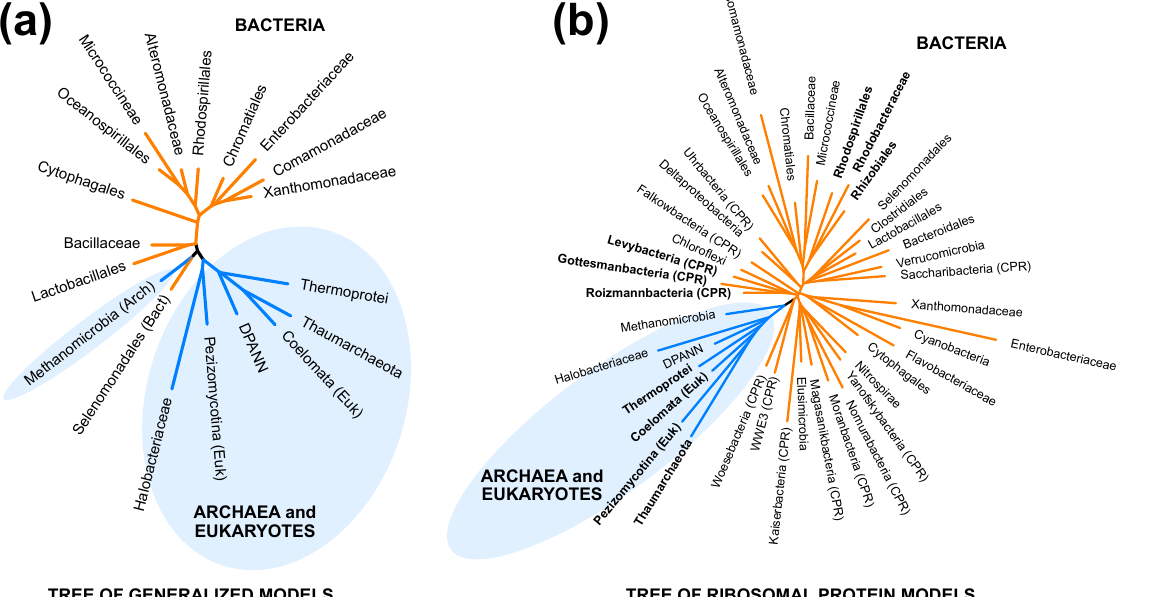
TREE OF RIBOSOMAL PROTEIN MODELS